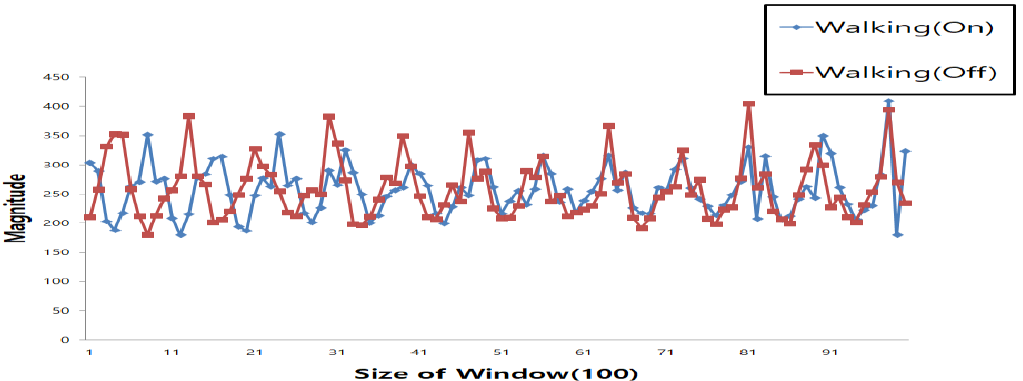
Figure 9. SVM during walking according to whether or not the chinstrap on the safety helmet was fastened.